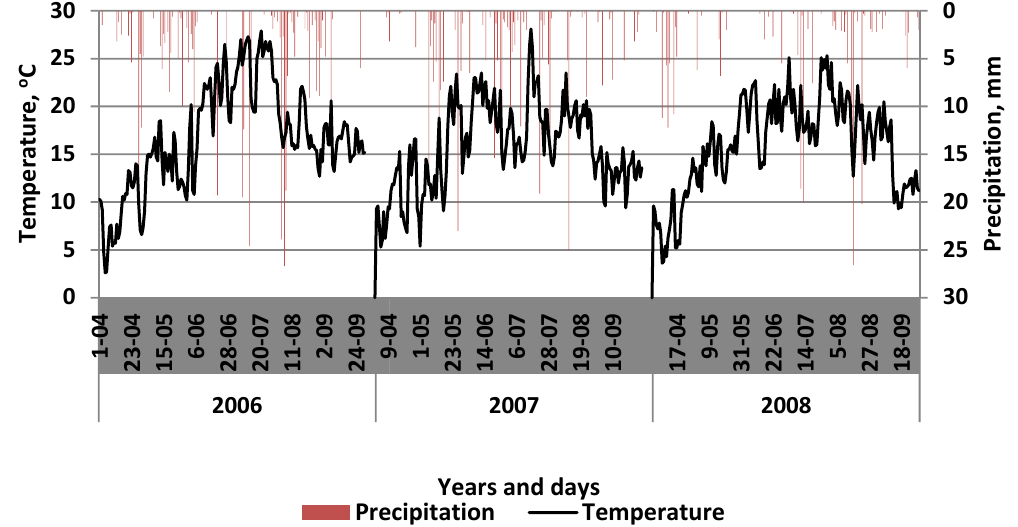
Figure 1. Daily mean air temperature and total precipitation at the Kicin Synoptic Station.